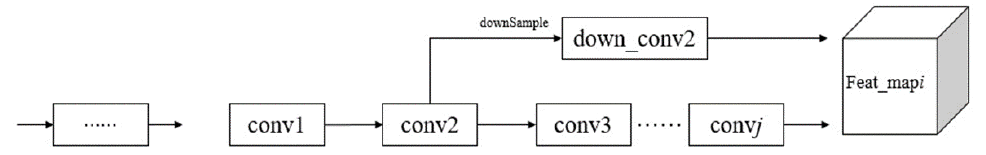
Figure 7. The basic structure of the feature extraction network.